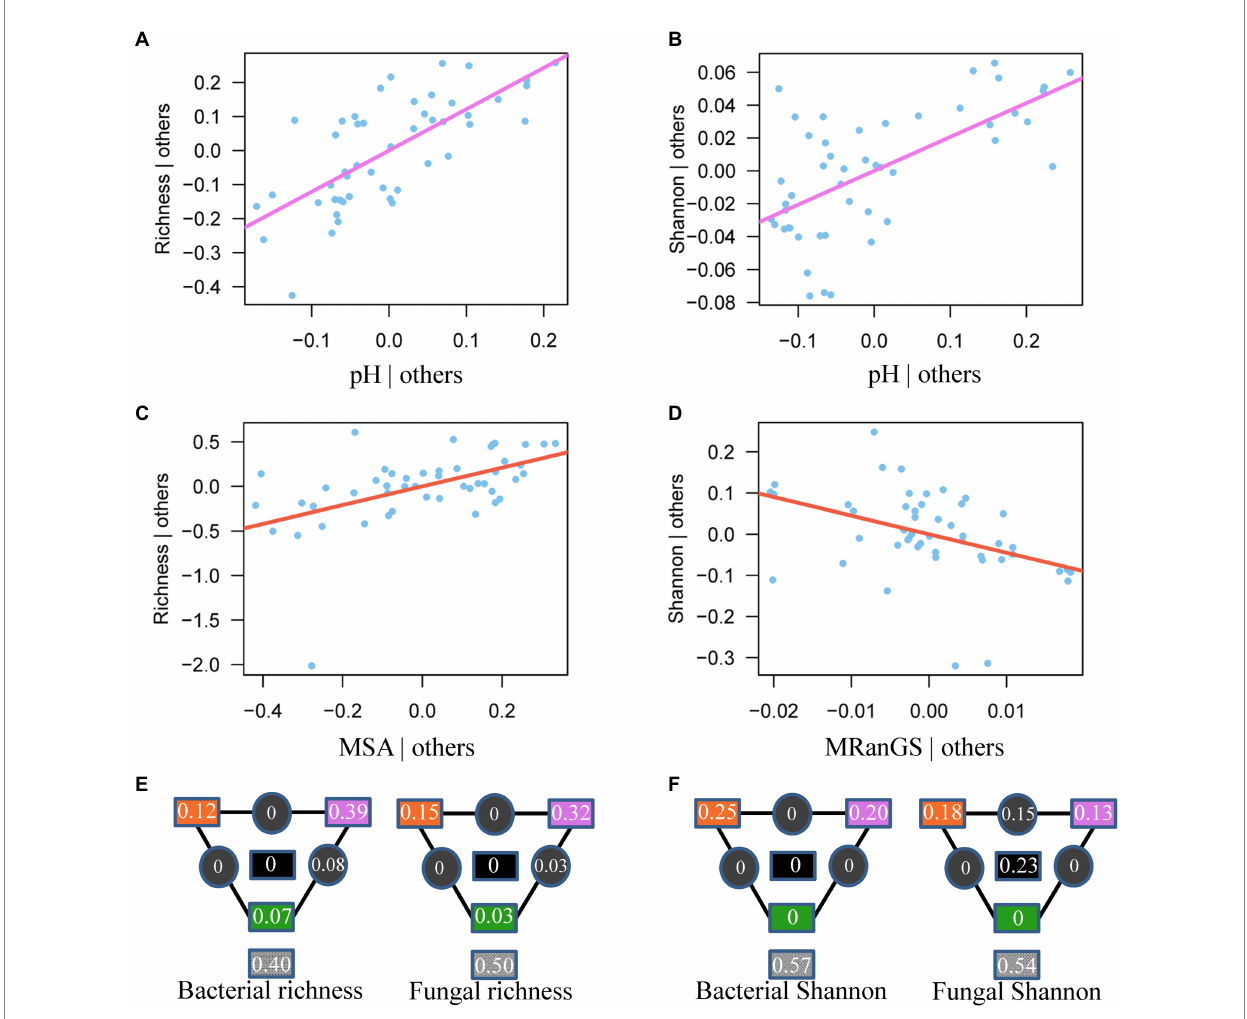
FIGURE 5 The most important predictor of bacterial (A,B) and fungal (C,D) diversity. Solid lines show the relationships between the best predictor based on AIC selection and microbial diversity after controlling for the effects of other significant variables in the model in Supplementary Table 5. MSA: Seasonality of soil moisture; MRanGS: Range of soil moisture in growing season. (E,F) Partitioning of bacterial and fungal diversity variance among important climatic factors (orange), soil chemistry (purple), vegetation (green), and their interactions (black). The values in gray squares are unexplained